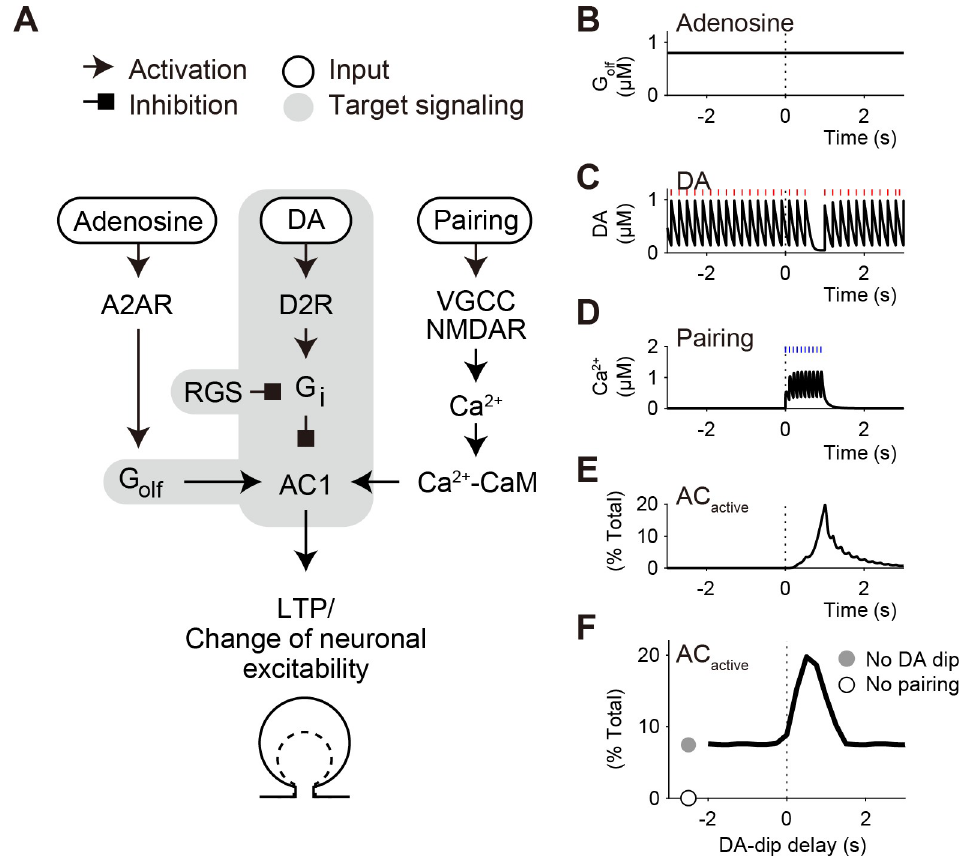
Fig 1. The D2 model performs the coincidence detection between DA dip and pre–post pairing. (A) Three signaling cascades toward AC1 for LTP in D2 SPNs of the striatum [10]. First, adenosine stimulates A2AR, which produces G olf - GTP to activate AC1. Second, basal DA signal leads to the activity of D2R, and then produces a GTP from of G i (G i - GTP), which inhibits the AC1 activity. Third, pre–post pairing signal leads to the postsynaptic increase in Ca 2+ -CaM that stimulates AC1. Signaling in the gray shaded area is modeled in the present D2 model. (B-F) Coincidence detection between DA dip and pre–post pairing. (B) In Iino et al. (2020), A2AR were pharmacologically activated to give a continuous signal of G olf -GTP [1]. (C) DA fibers are optogenetically stimulated tonically at 5Hz (red lines). The tonic stimulation accompanies a 0.5-s pause (DA dip, t DA,delay = 0.5 s), as a representation of unexpected reward omission. (D) Sensory/action signals are represented by pre–post pairing at 10 times and 10 Hz (blue lines), which gives a transient Ca 2+ signal. (E) The G olf , G i , and Ca 2+ -CaM signals transiently activates AC1 ( AC active ). (F) A timing window for DA-dip delay on the maximal amplitudes of AC active . The D2 model is simulated under the non-competitive binding among G olf , G i , and Ca 2+ -CaM (standard non-competitive model; see S1 Fig and section A in S1 Appendix ).